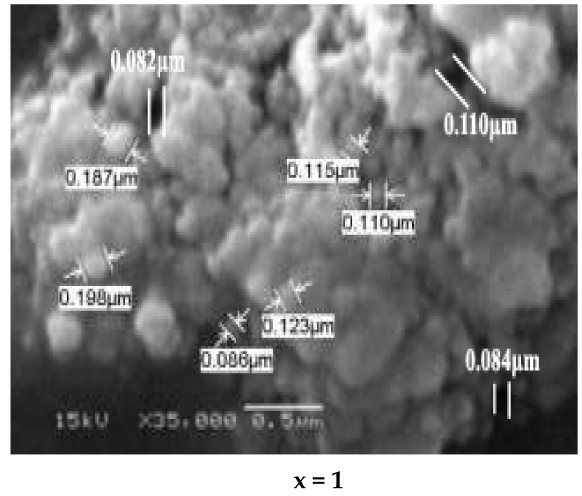
Figure 6. Grain size of Ni + 2